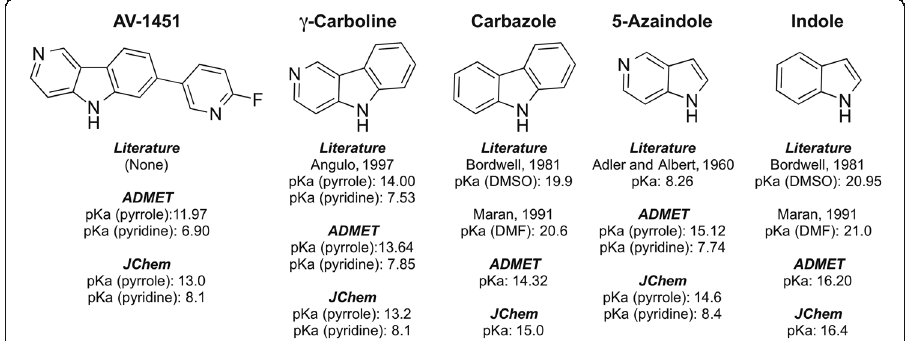
Fig. 4 Predicted pKa of [ 18 F]AV1451 by property prediction and comparison of analogues by literature and predicted pKa values indicates the gamma-carboline NH of [ 18 F]AV1451 is more acidic than a typical indole, carbazole or